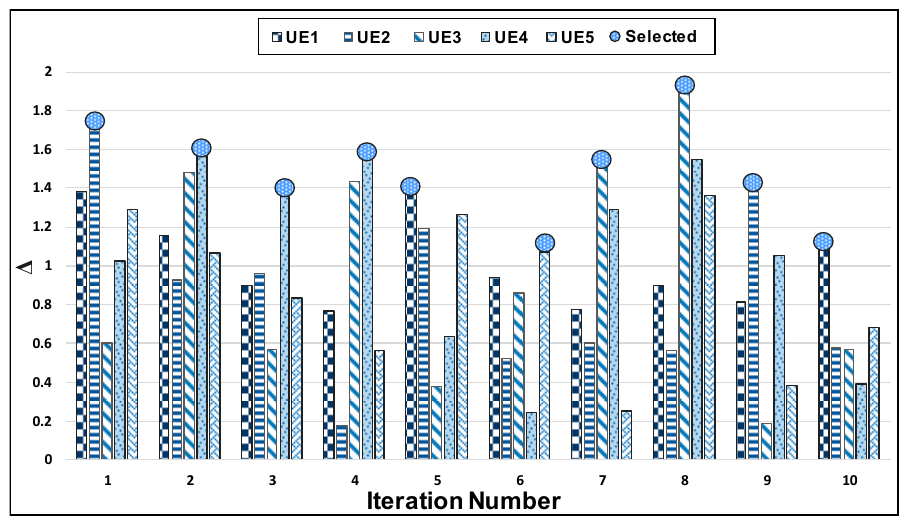
Figure 8. Selection of the UE with best Δ values.